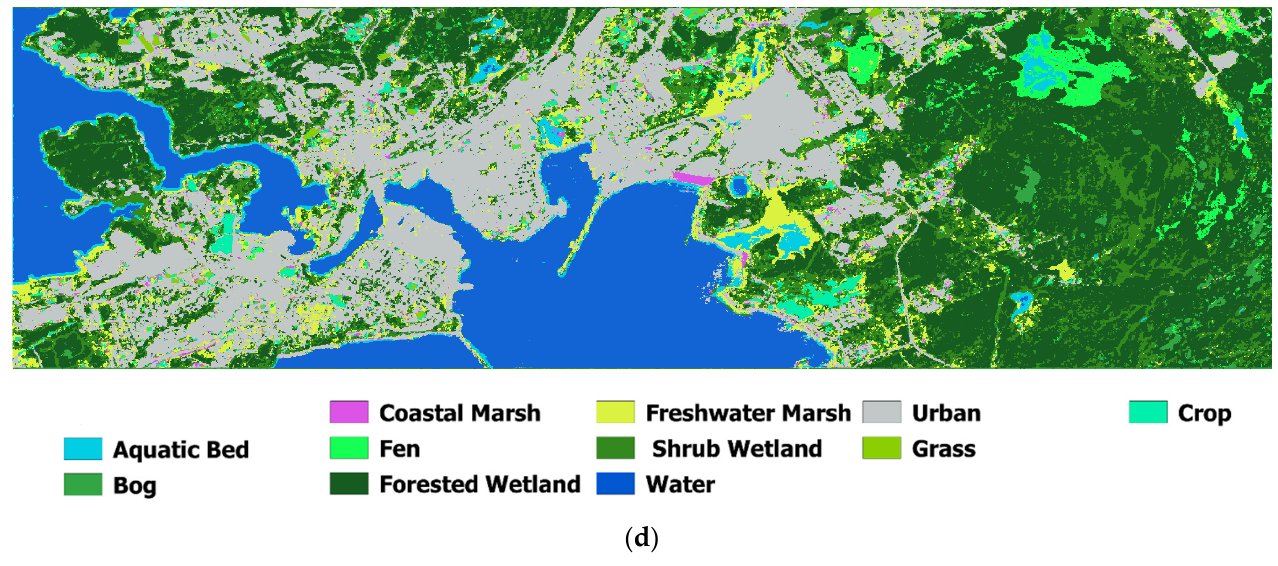
Figure 7. Coastal wetland classification using: ( a ) Sentinel-2 true color of the study area, ( b ) the VGG-16 network (Sentinel-2 features), ( c ) VGG-16 and second 3D CNN networks (Sentinel-1 and Sentinel-2 features, respectively), and ( d ) the multi-model network. Table 5. Results of the RF classifier with different data sources in terms of average accuracy, precision, F1-score, and recall (AB = aquatic bed, BO = bog, CM = coastal marsh, FE = fen, FM = freshwater marsh, FW = forested wetland, SB = shrub wetland, W = water, U = urban, G = grass, C = crop, AA = average accuracy, OA = overall accuracy, K = kappa, S1 = Sentinel-1, S2 = Sentinel-2, DEM = DEM from LiDAR